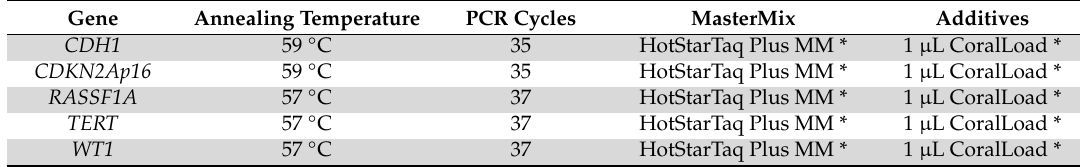
Table 7. Optimized PCR